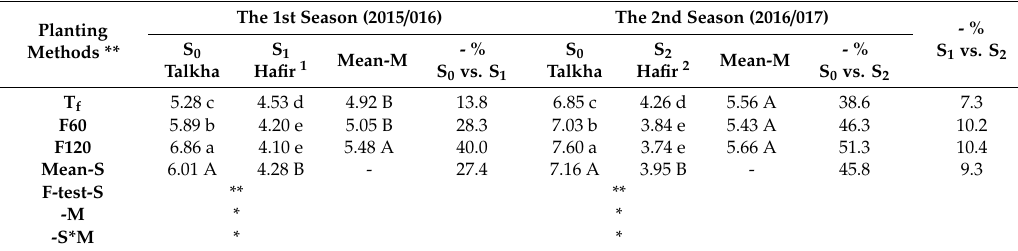
Table A2. Grain yield (ton ha − 1 ) under di ff erent planting methods (M) and salinity conditions (S*). Planting Methods **